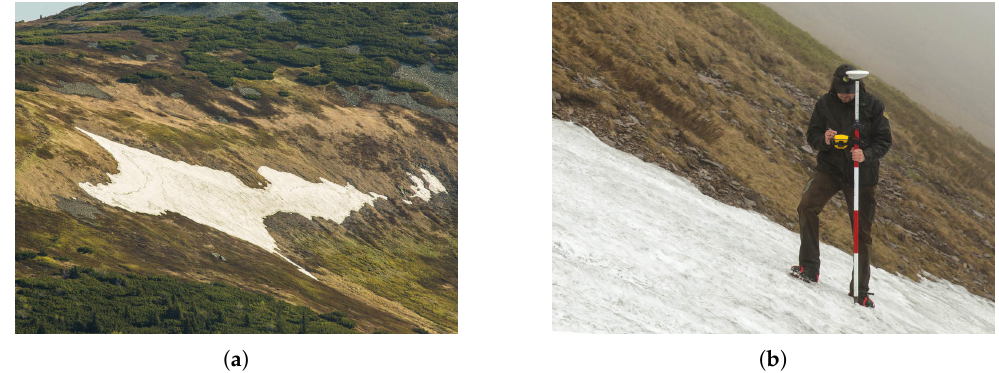
Figure 2. The isolated Mapa Republiky snow field during the spring season ( a ), and ground survey-based point determination of the snow field shape ( b